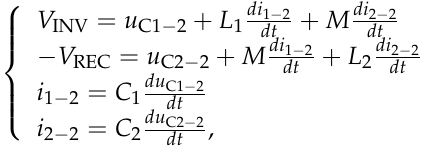
where the subscript “ − 2” denotes that the symbols are in the interval of t 0 < t < T /2. With considerations of the boundary conditions, namely